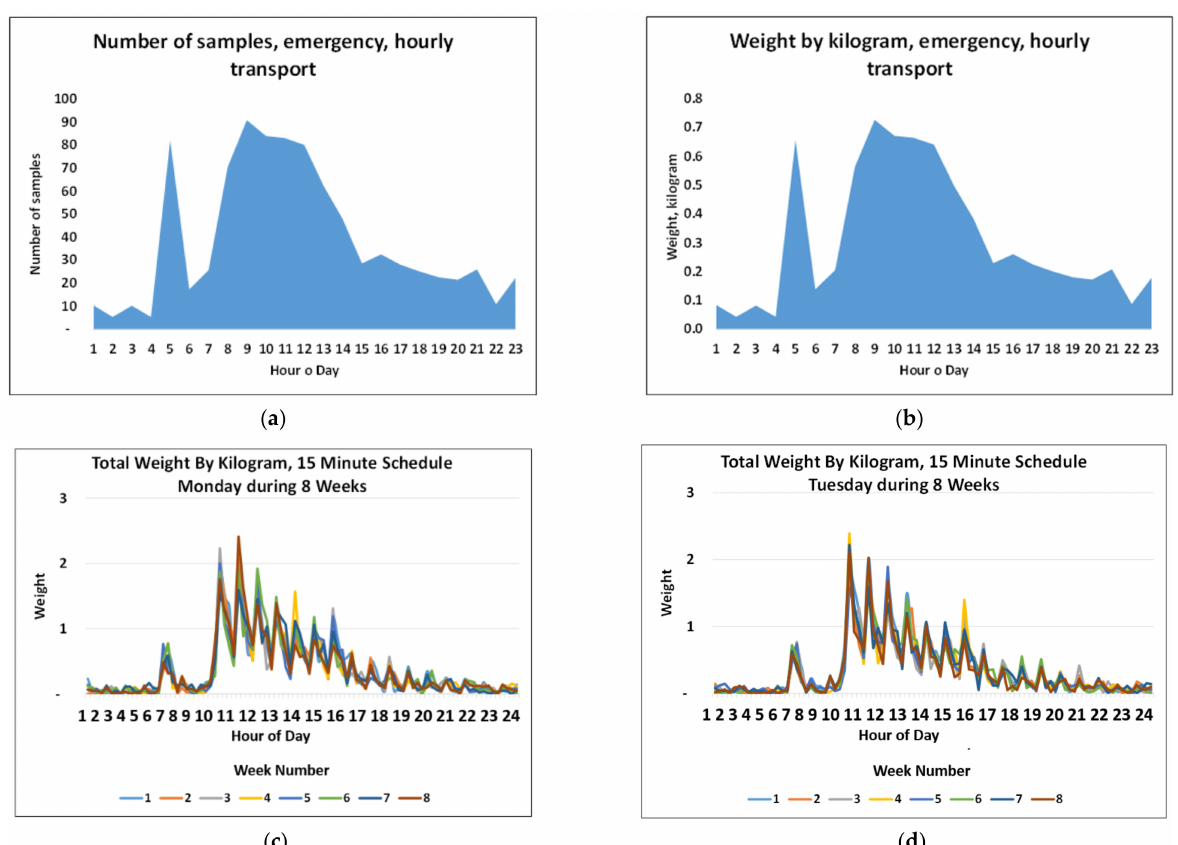
Figure 7. ( a ) Number of emergency laboratory samples. ( b ) Weight of samples corresponding to figure a. ( c ) Variation in the load weight on Mondays over 8 weeks for a 15 min frequency. ( d ) Variation in the load weight on Tuesdays over 8 weeks for a 15 min flight frequency.